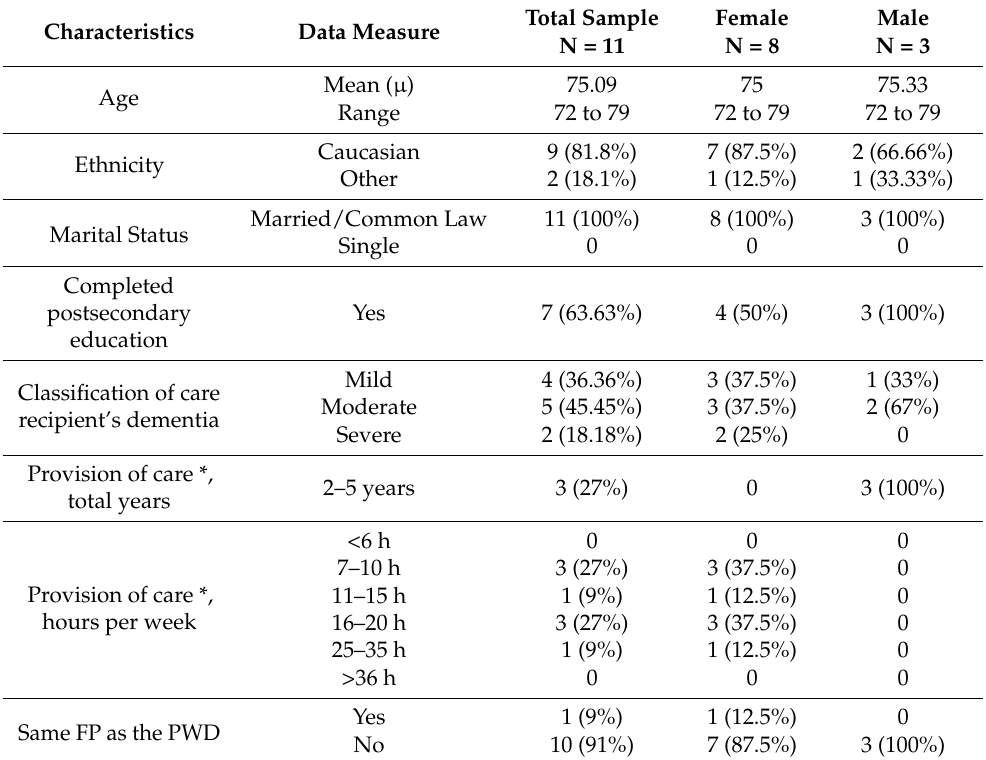
Table 1. Caregiver participant demographics.